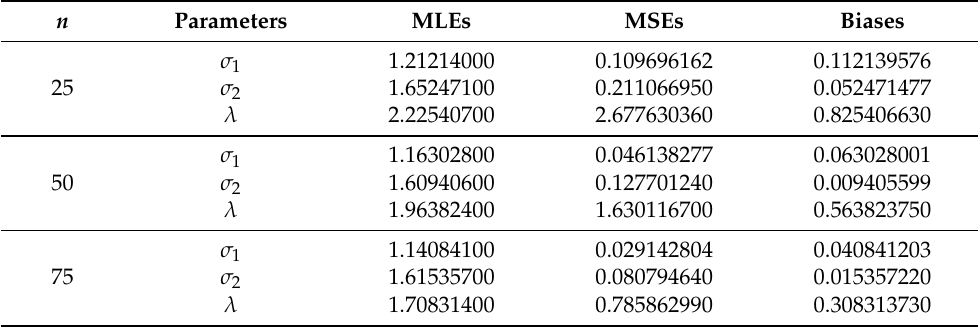
Table 2. The results of the SimS of the NMFWE model for σ 1 = 1.1, σ 2 = 1.6, and λ =